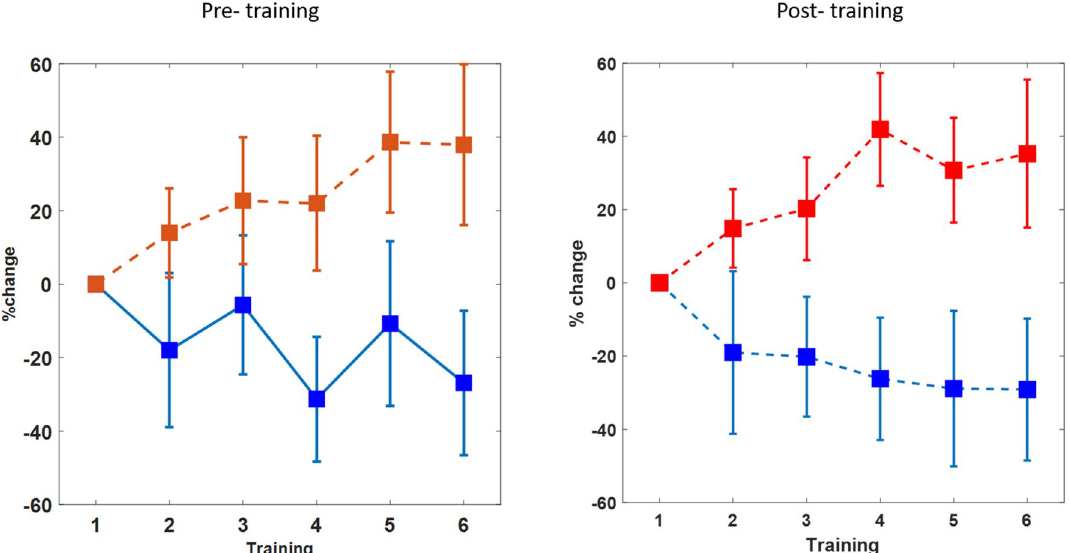
Figure 3. Comparing the pain discrimination between the pre-and post-training period (pre-training presented left and is a repetition from Fig. 2, but here directly compared to the post-training (right panel)). The differentiation between the groups was slightly enhance in the measure after each training, but not reliably different to the pre-training measure indicating the induction of longer lasting effects by the training. Error bars depict ± 1 standard error of the mean (SEM, n = 10 in every group).